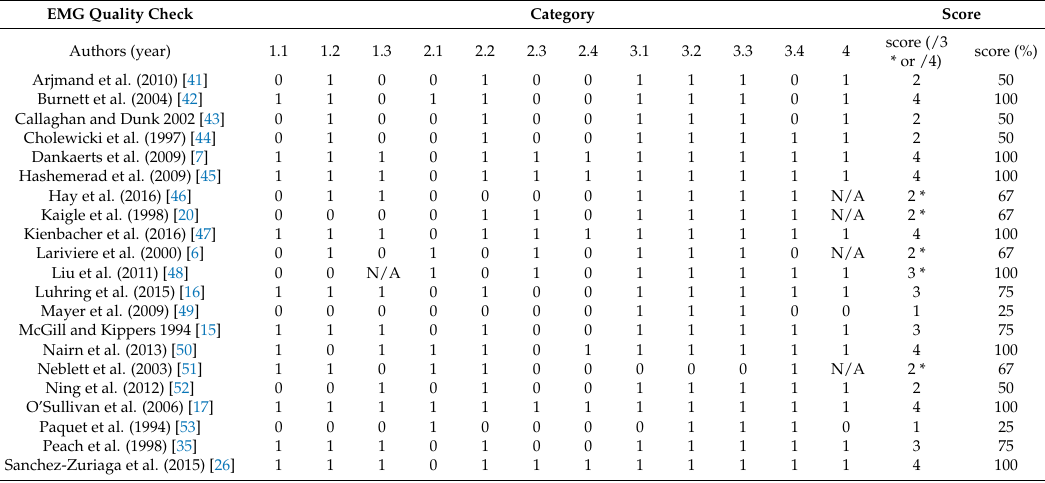
Table 2. Electromyography (EMG) quality assessment scores (* Studies that did not require normalisation were rated using a 3 point scale instead of 4) as per Abboud et al. (2017) [13]. EMG Quality Check